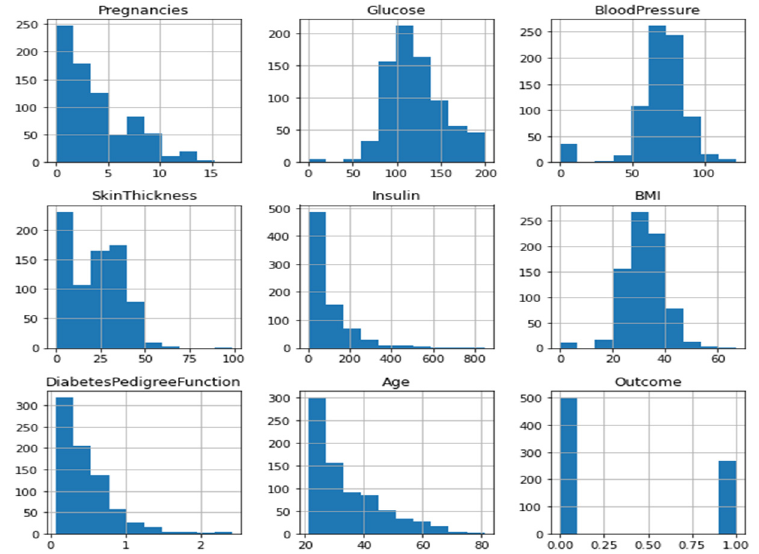
Figure 1. Representation of input parameter.